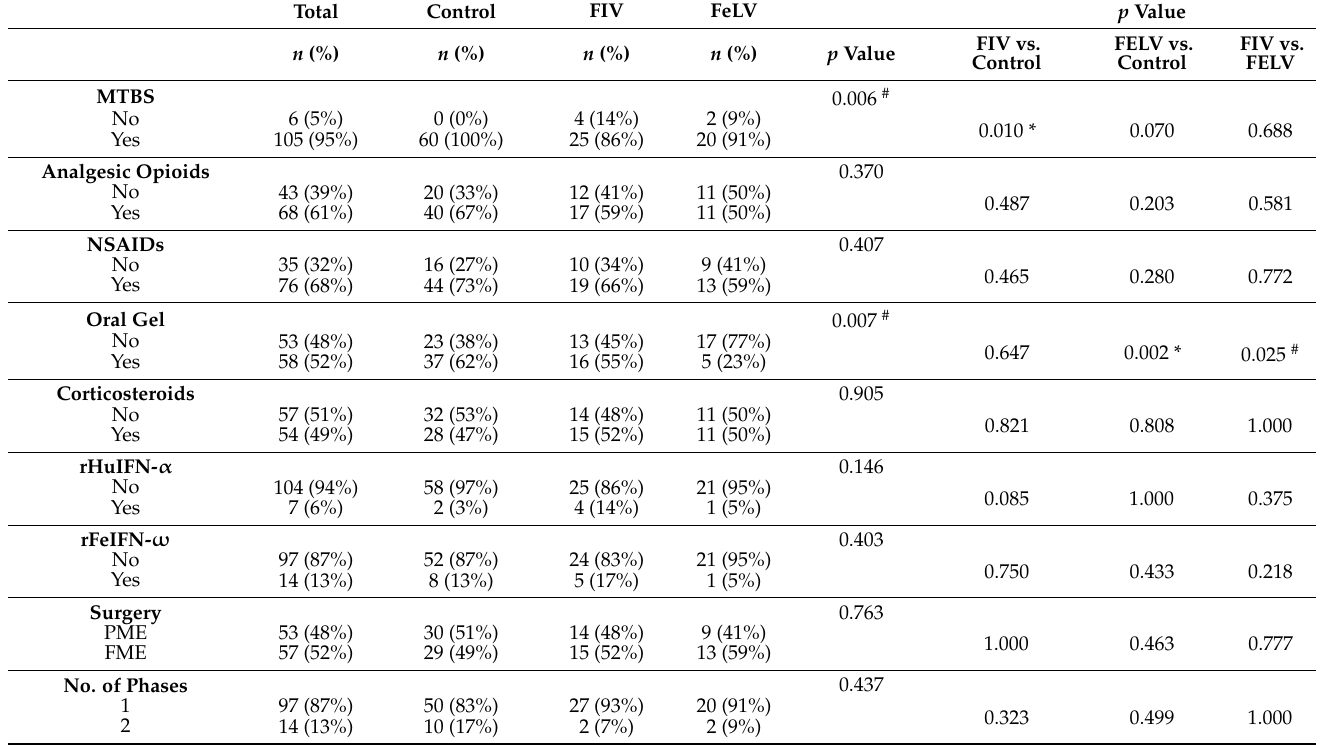
Table 4. Treatment variables.